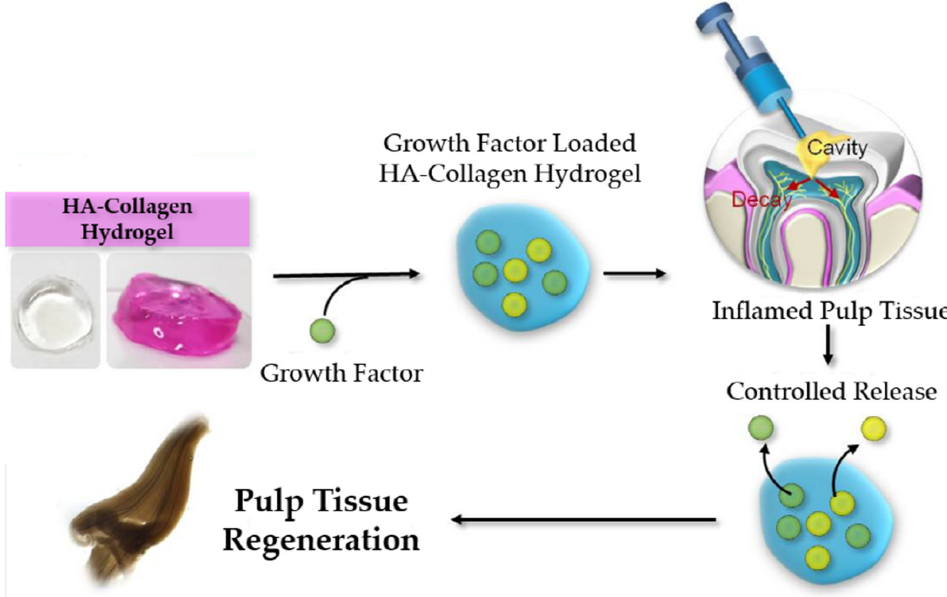
Figure 3. A schematic description of the use of growth factors released from HA-collagen hydrogel for pulp tissue regeneration.